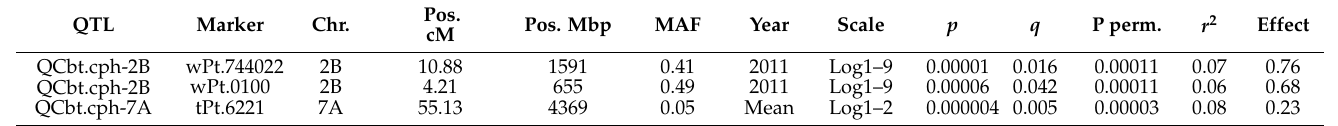
Table 3. QTL for common bunt in a population of 248 wheat accessions. Given are the QTL des- ignation, the name of the linked DArT marker (with chromosome and position (Pos.), the minor allele frequency (MAF), the year the QTL was observed, the log scale used in the association analysis, the p -value of the association test, the respective q -value, the 95th percentile of 20,000 permutation tests. The variance explained by the marker is given as the r 2 of the difference between the model fit with and without that marker. Marker effects are given as BLUEs from Model. QTLs were named following the recommendation in